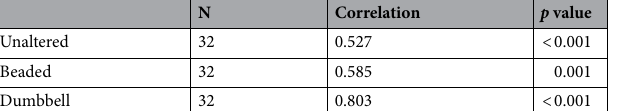
Table 3. Spearman’s rho correlation for inter-observer agreement. All samples included in analysis were included for inter-observer agreement testing, except for the sample from Durrington Walls (DW1). Significance set at p < 0.01.